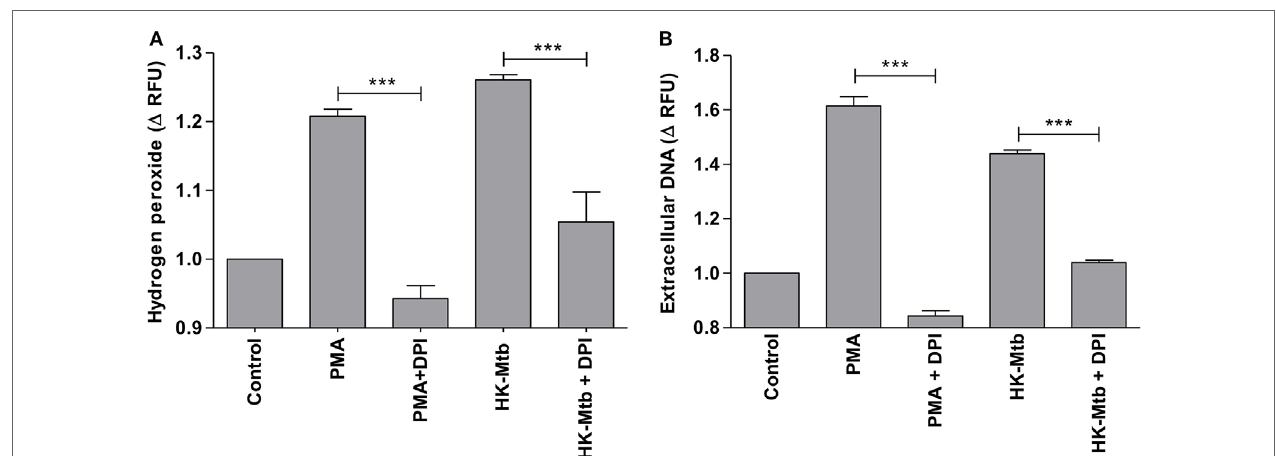
FigUre 5 | Induction of MCETs by heat-killed Mtb (HK-Mtb) depends on NADPH oxidase. (a) Hydrogen peroxide was evaluated in HMC-1 mast cells that were left unstimulated (control) or stimulated for 90 min with PMA or HK-Mtb. A group of cells was incubated with the NADPH oxidase inhibitor, diphenyliodonium (DPI), previous to activation. The graph represents the change in fluorescence ± SD of stimulated cells compared to unstimulated cells. *** p < 0.001 as indicated. (B) Extracellular DNA was evaluated in HMC-1 mast cells after 2 h of stimulation with PMA or HK-Mtb in the presence or absence of DPI. The graph represents the change in fluorescence ± SD of stimulated cells compared to the control. *** p < 0.001 as indicated.